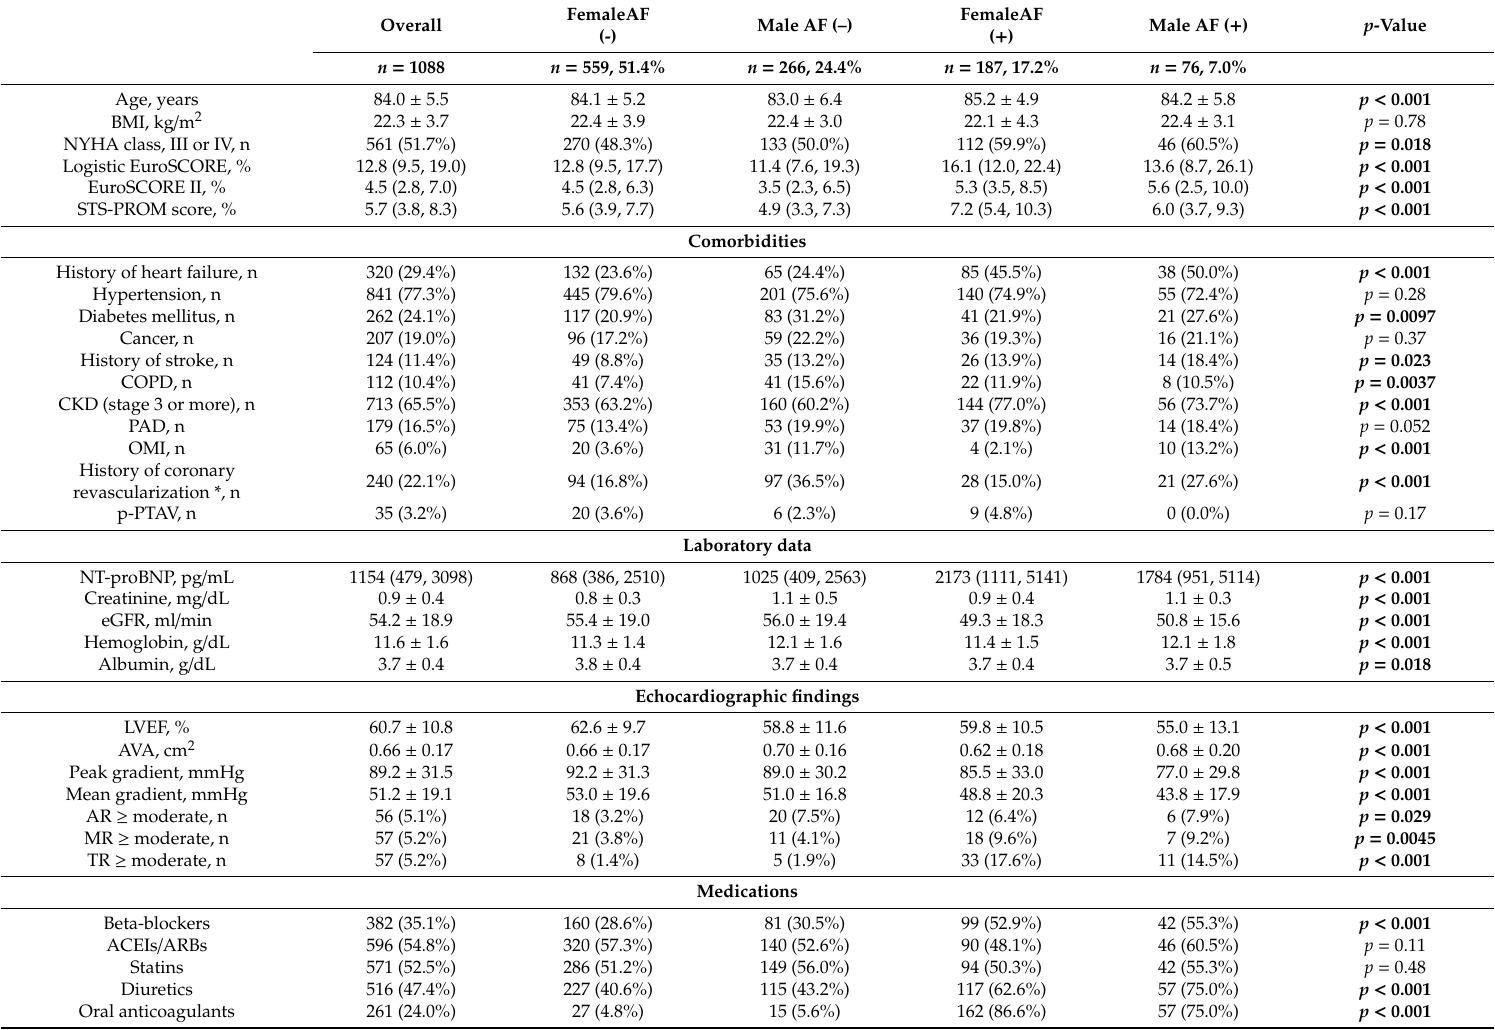
Table 1. Baseline and procedural characteristics of study patients categorized by gender and